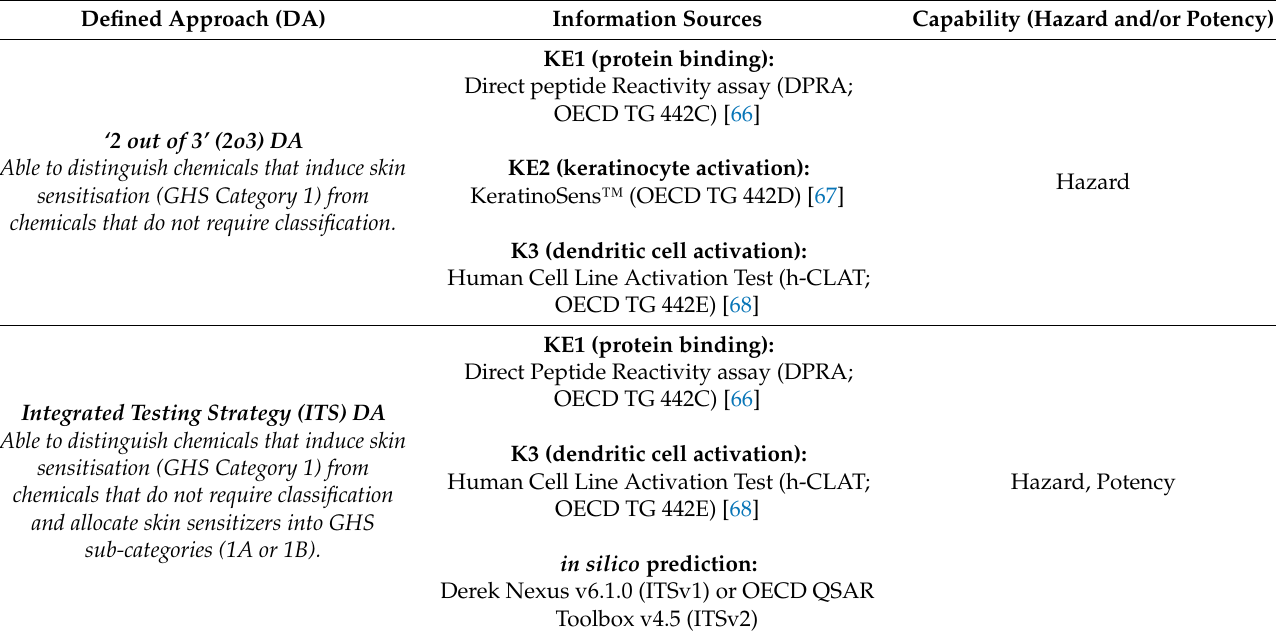
Table 6. Summary of non-animal defined approaches (DAs) included in OECD TG 497 [82]. Defined Approach (DA) Information Sources Capability (Hazard and/or